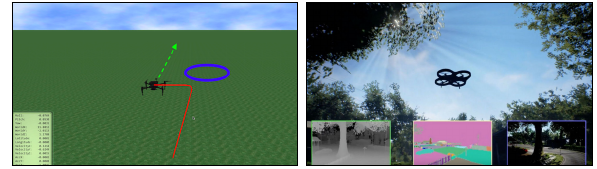
Figure 7. The two flight simulators used for Hardware-in-the- Loop testing. While the main view in (b) shows a third-person view point on the scene, the three smaller displays at the bottom reveal the disparity map, an object segmentation and camera im- age from the UAV point of